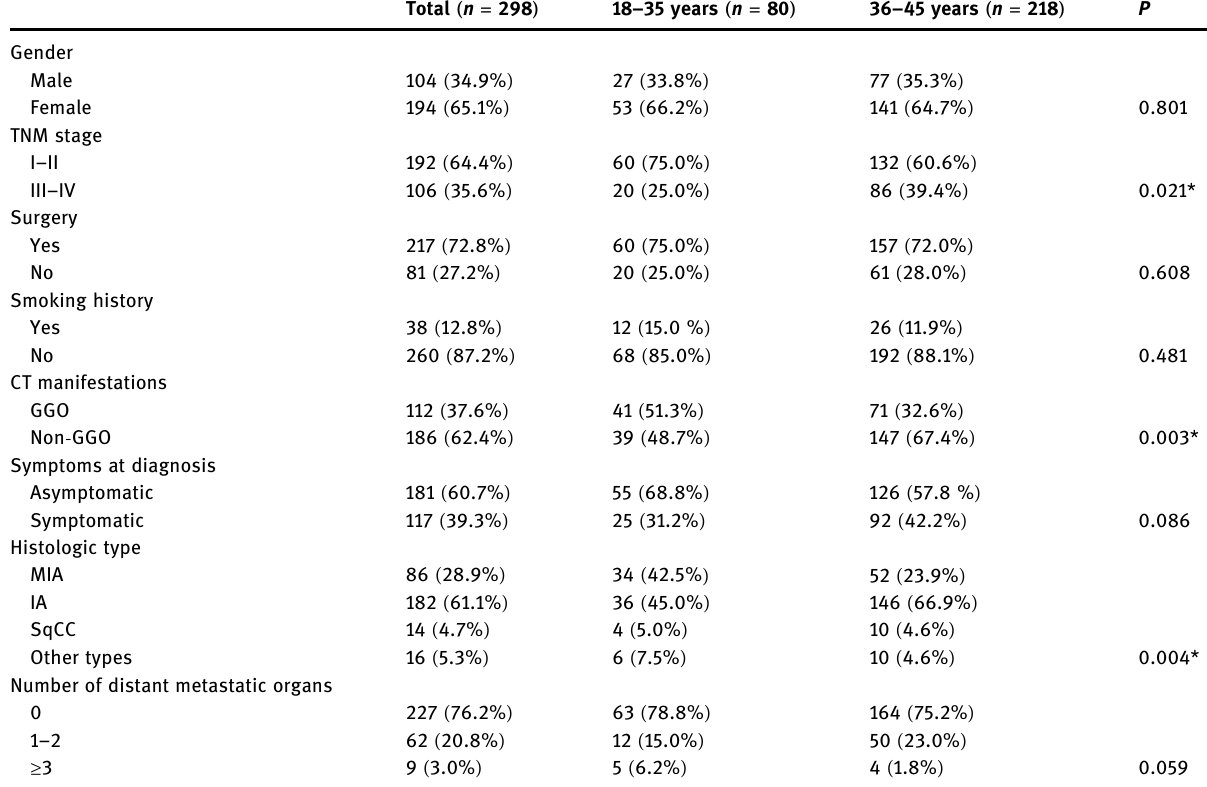
Table 1: Comparison of clinicopathological fi ndings of the young patients with NSCLC between 18 – 35 years old group and 36 – 45 years old